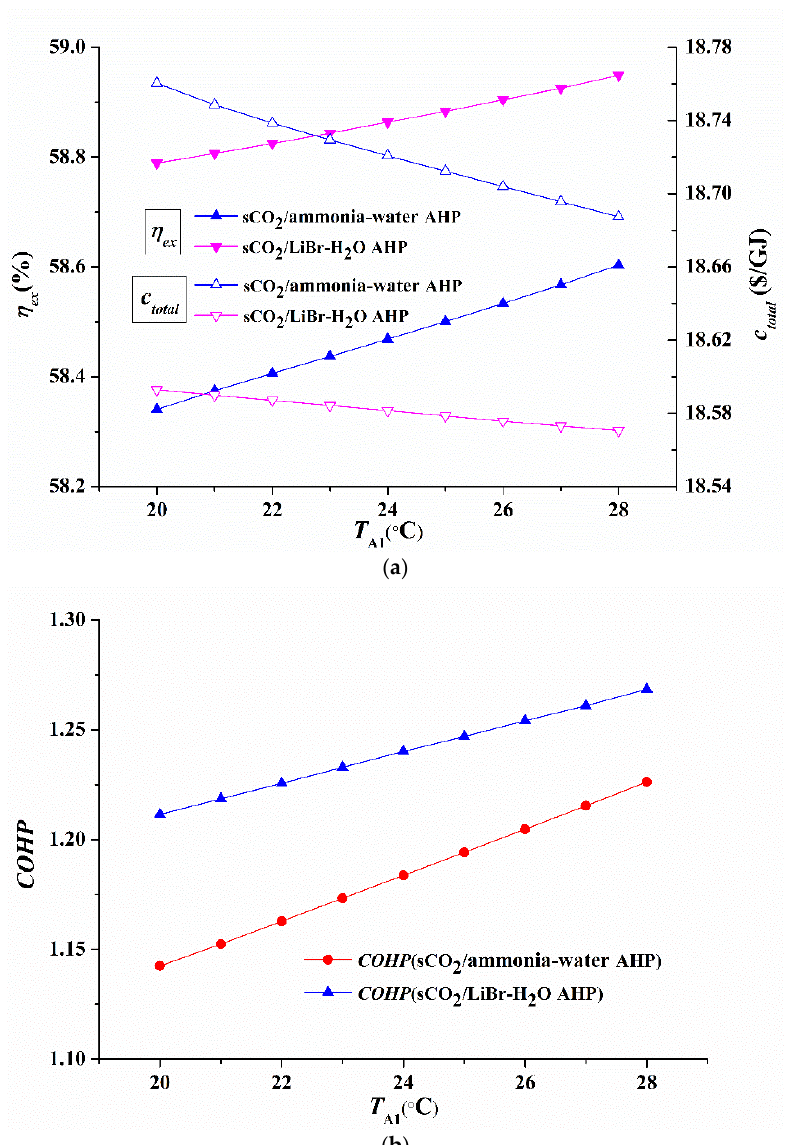
Figure 8. Variation trends of system performance indicators with T A1 for different thermal systems: ( a ) η ex and c total ; ( b ) COHP .